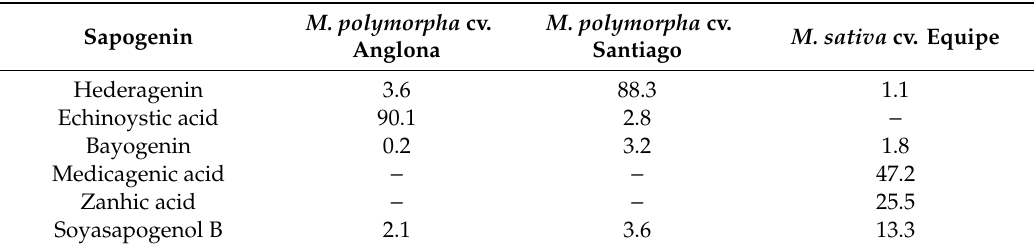
Figure 1. Chemical structure of the most abundant sapogenins (R = R 1 = H) detected in the Medicago spp. used in this study. R = R 1 = sugar or sugar chain: bidesmosidic saponins; R = sugar or sugar chain, R 1 = H: monodesmosidic saponins. Table 1. Percentage composition of the most abundant sapogenins detected in the Medicago saponin mixtures used in this investigation. For chemical structures see Figure 1.